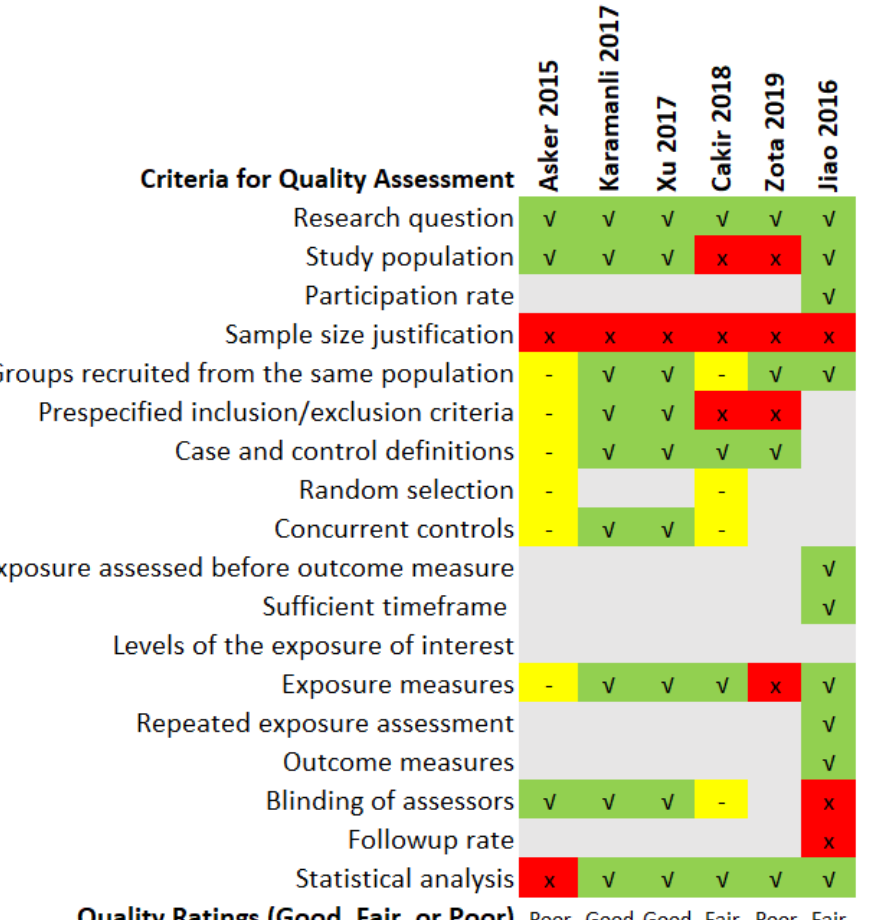
Figure 4. Quality assessment ratings of the included studies [21–26]. Legend: Green: Yes; Red: No; Gray: Not Applicable; Yellow: Not Reported or Cannot